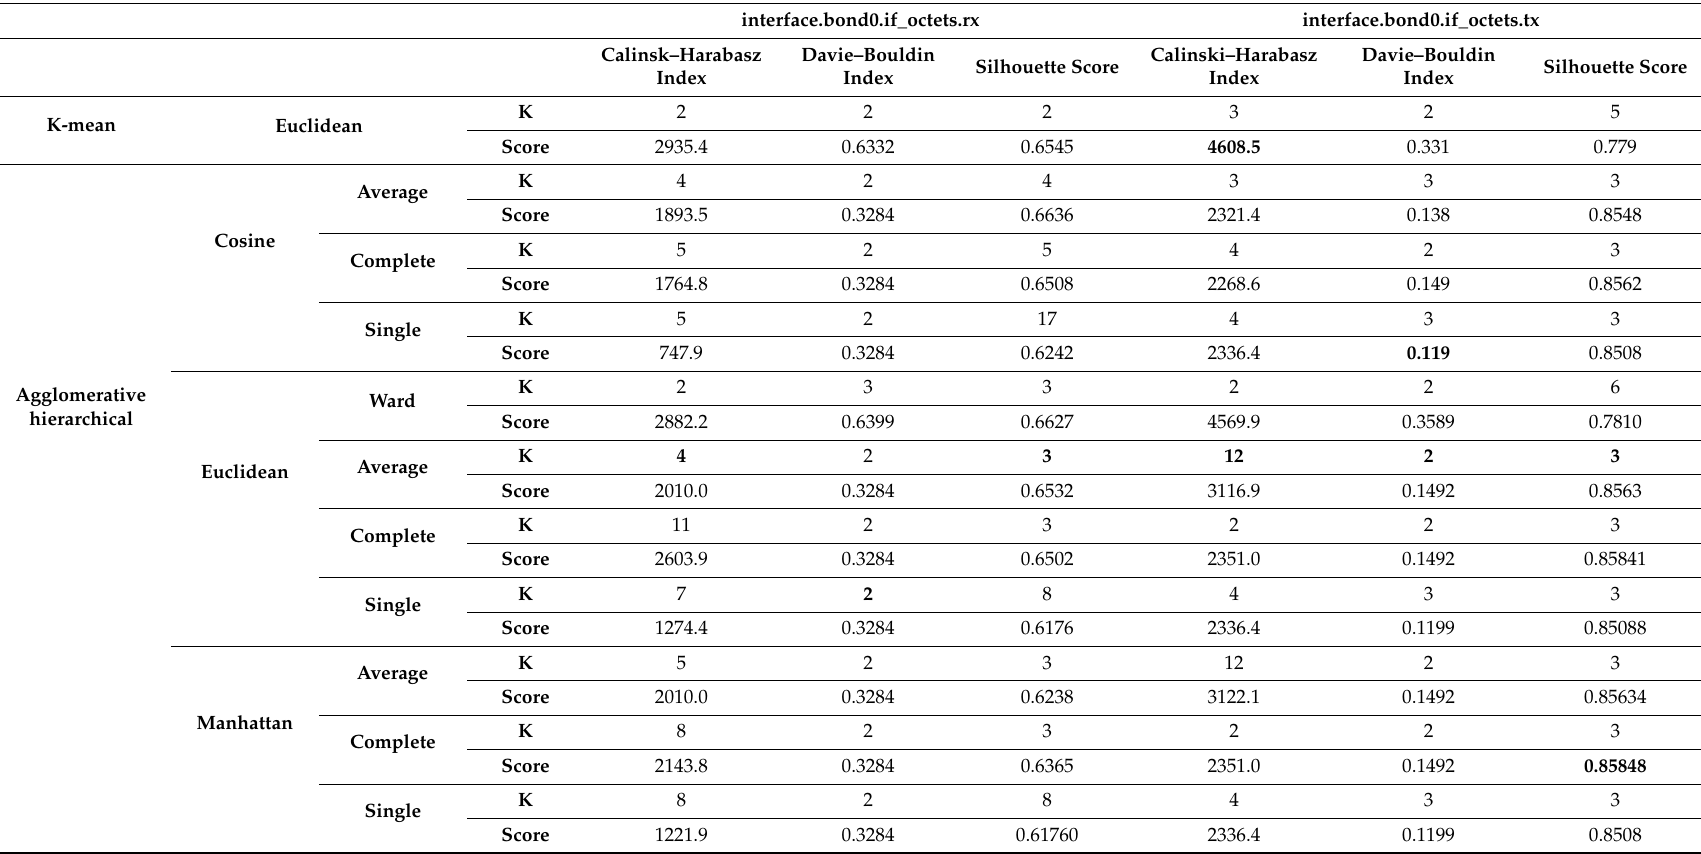
Table 9. Validation experiment: